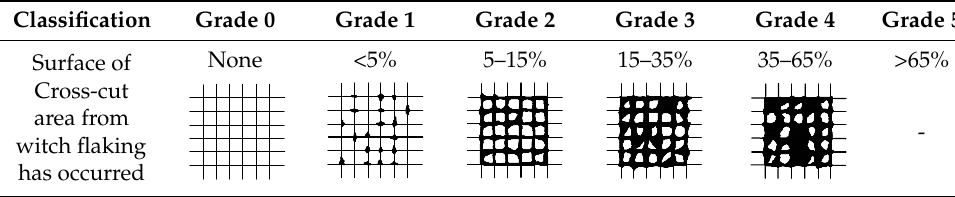
Table 1. Classification of adhesion according to the Cross-cut test.